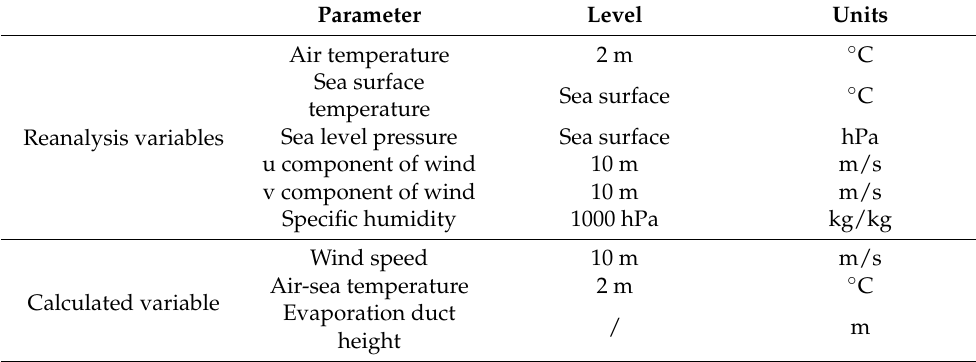
Table 1. Primary atmospheric variables obtained from the reanalysis data and those calculated from the available data.